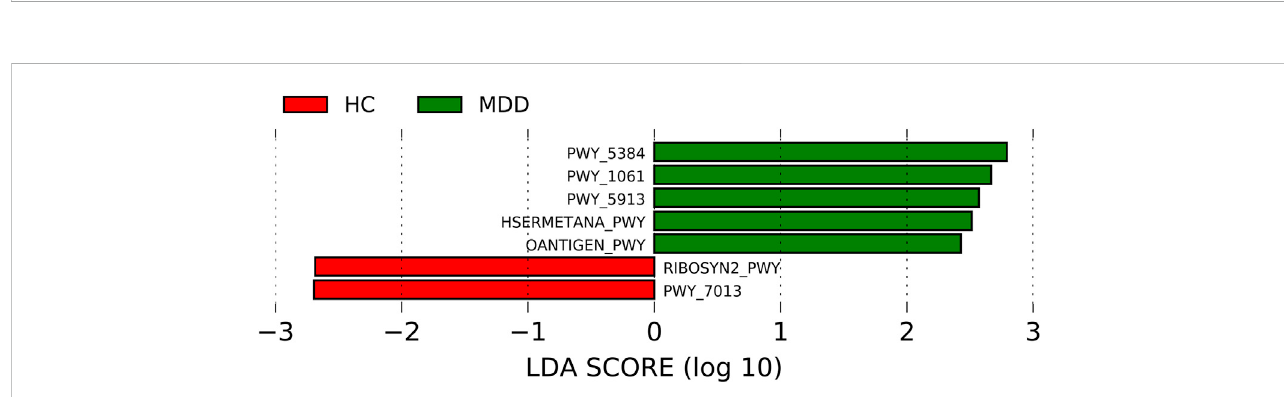
FIGURE 4 Linear discriminant analysis effect size (LEfSe) histograms for the comparisons of major depressive disorder (MDD) versus healthy controls of pathways.